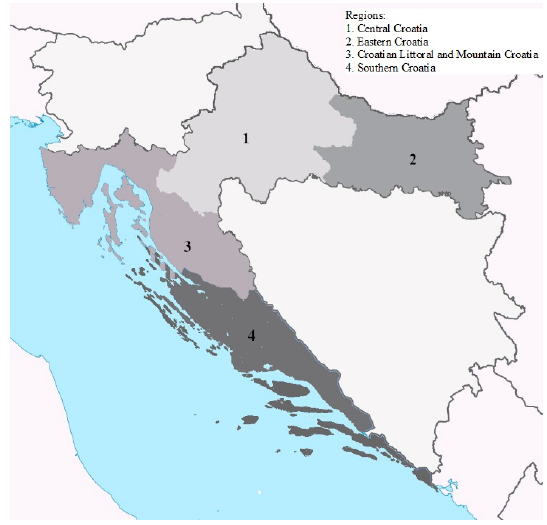
Figure 1. Map of Croatia with four indicated regions. Prior to analysis, milk samples were defrosted and centrifuged for 10 min at 3500× g at 10 °C. The upper cream layer was removed by aspirating through a Pasteur pipette.